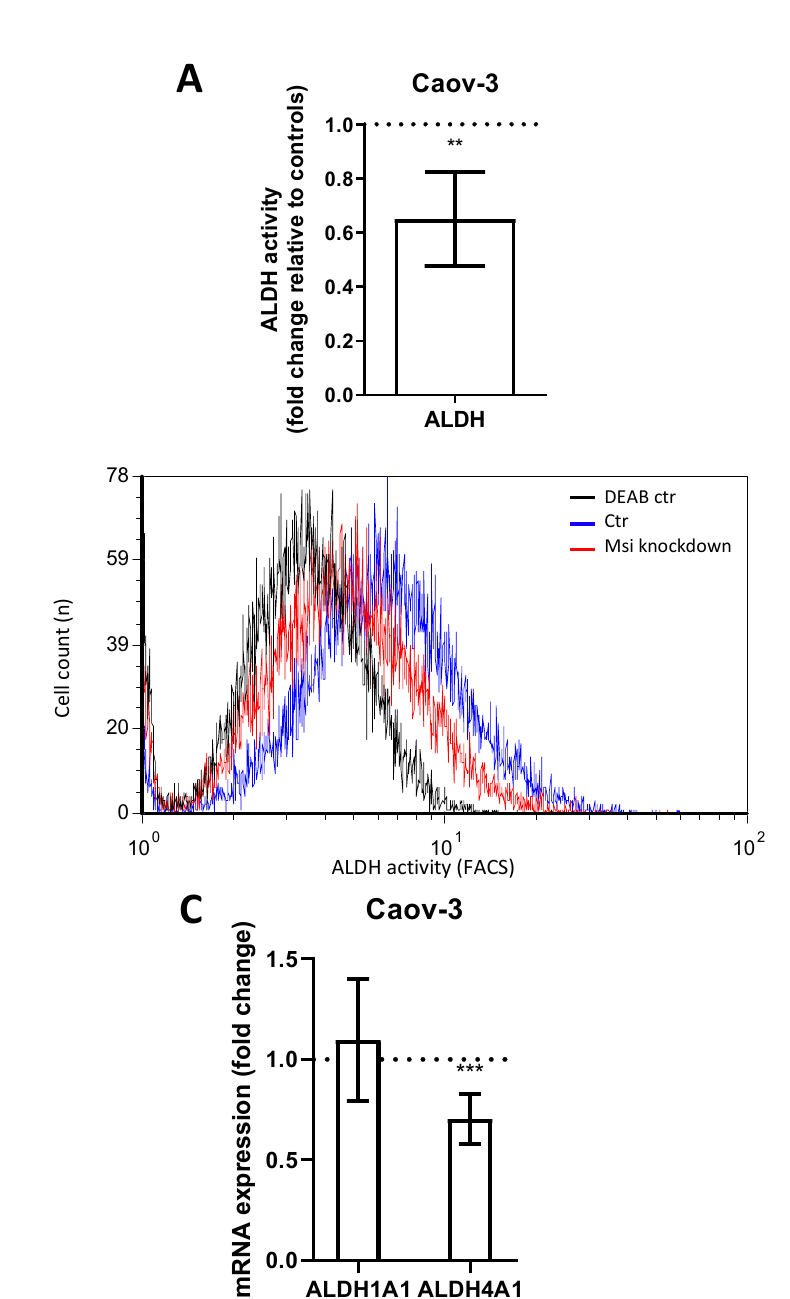
Figure 3. Aldehyde dehydrogenase activity in Caov-3 cells is downregulated after Musashi-1 and Musashi-2 inhibition. ( A ): Aldehyde dehydrogenase activity as determined by flow cytometry is reduced after dual inhibition compared to controls. ( B ): Representative flow cytometric measure- ments with “negative controls” shown in the presence of the ALDH-inhibitor diethylaminobenzalde- hyde ( DEAB ). ( C ): ALDH4A1 is downregulated subsequent to dual inhibition, while ALDH1A1 is unchanged in quantitative polymerase chain reaction (qPCR) measurements. All experiments were repeated at least three times in triplets. p values < 0.05 were deemed significant (** p < 0.01; *** p < 0.001; error bars indicate standard error of the mean (s.e.m.)).